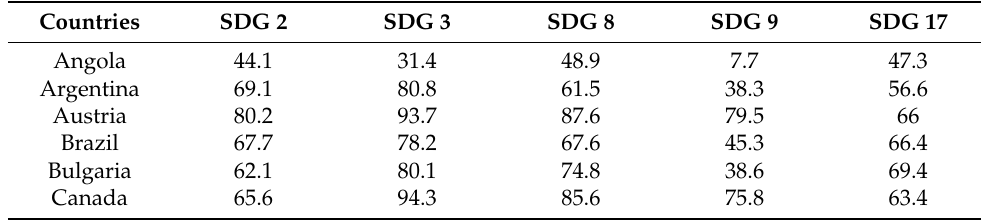
Table A3. Values of Economic